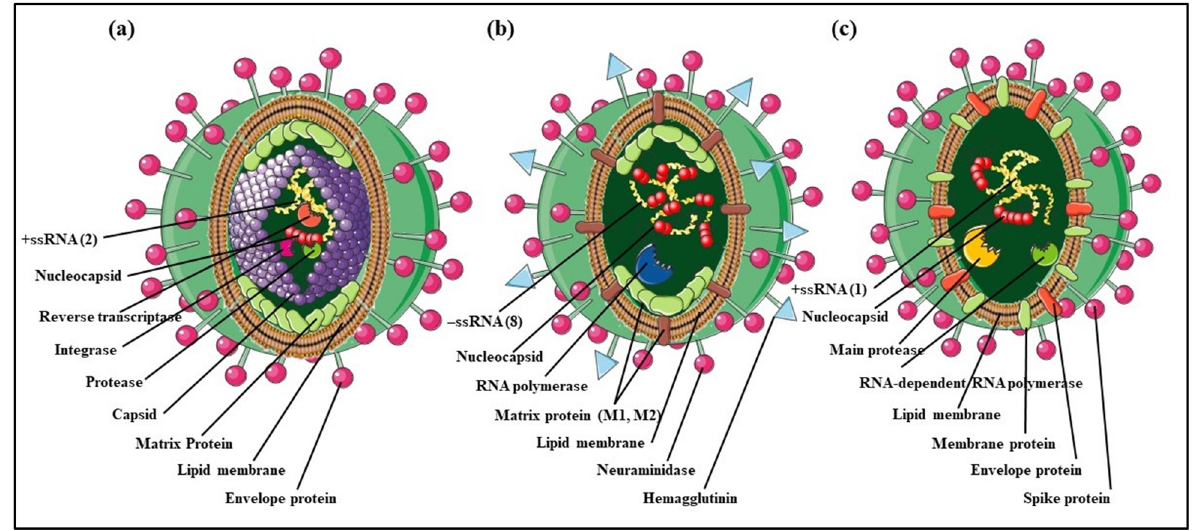
Figure 1: Schematic representation showing the structure of: ( a ) HIV, ( b ) IAVs, and ( c ) SARS - CoV -